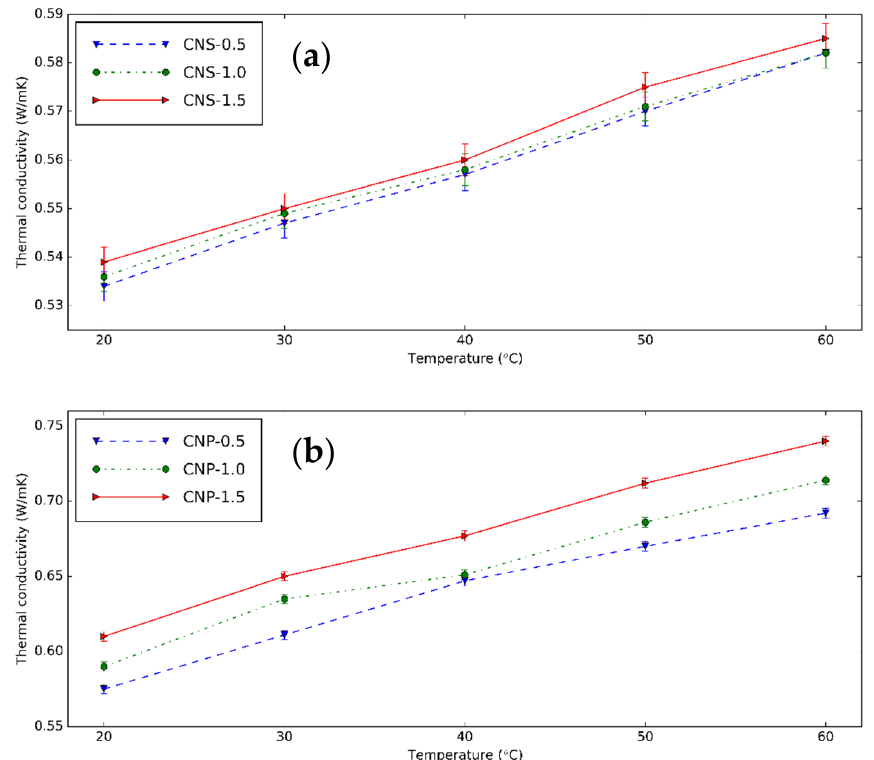
Figure 11. k of ( a ) CNS and ( b ) CNP nanofluids with different concentrations at different temperatures.